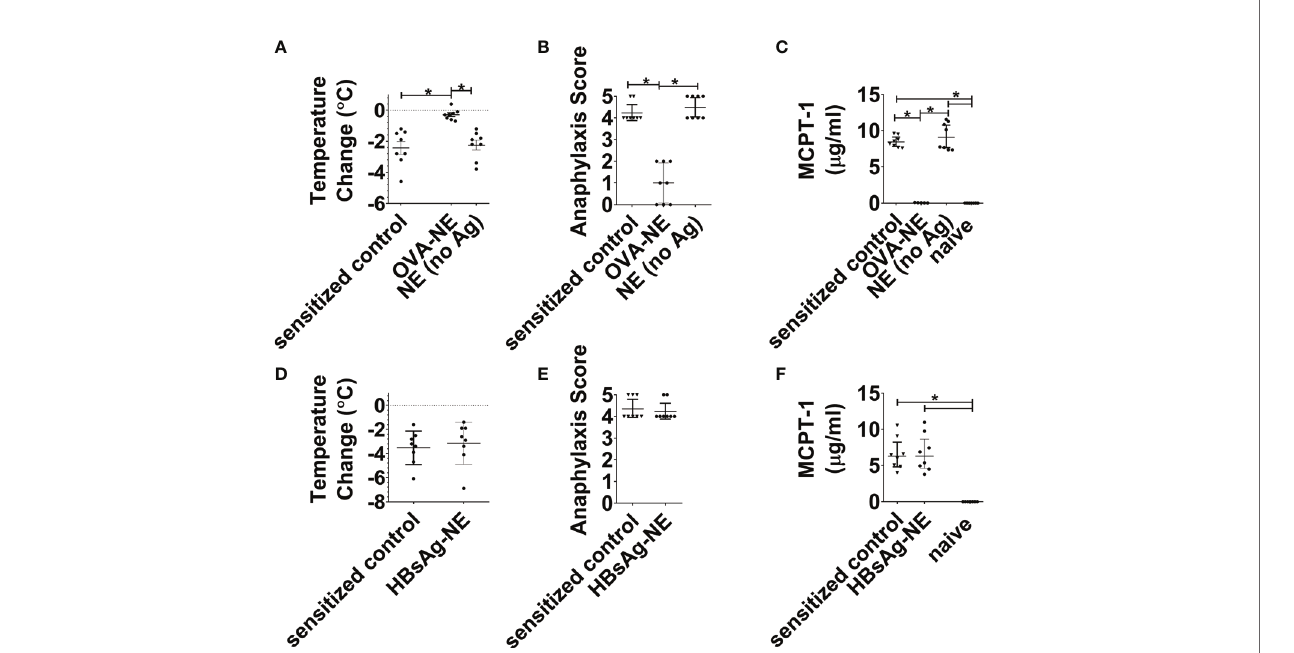
FIGURE 3 | Intranasal administration of NE without allergen does not suppress the allergic response. (A – C) Mice were sensitized with OVA and peanut-alum and treated i.n. with 3 administrations of PBS (sensitized control), OVA-NE (OVA-NE) or NE only (no antigen) or Mice were challenged orally with OVA and temperature change and symptoms of anaphylaxis were monitored. Serum MCPT-1 levels were determined by ELISA. (D – F) In a separate experiment, mice were similarly sensitized with OVA and peanut with alum and treated i.n. with 3 administrations of PBS (sensitized control) or hepatitis B surface antigen-NE (HBsAg-NE). Statistically signi fi cant differences (p < 0.05) are indicated by